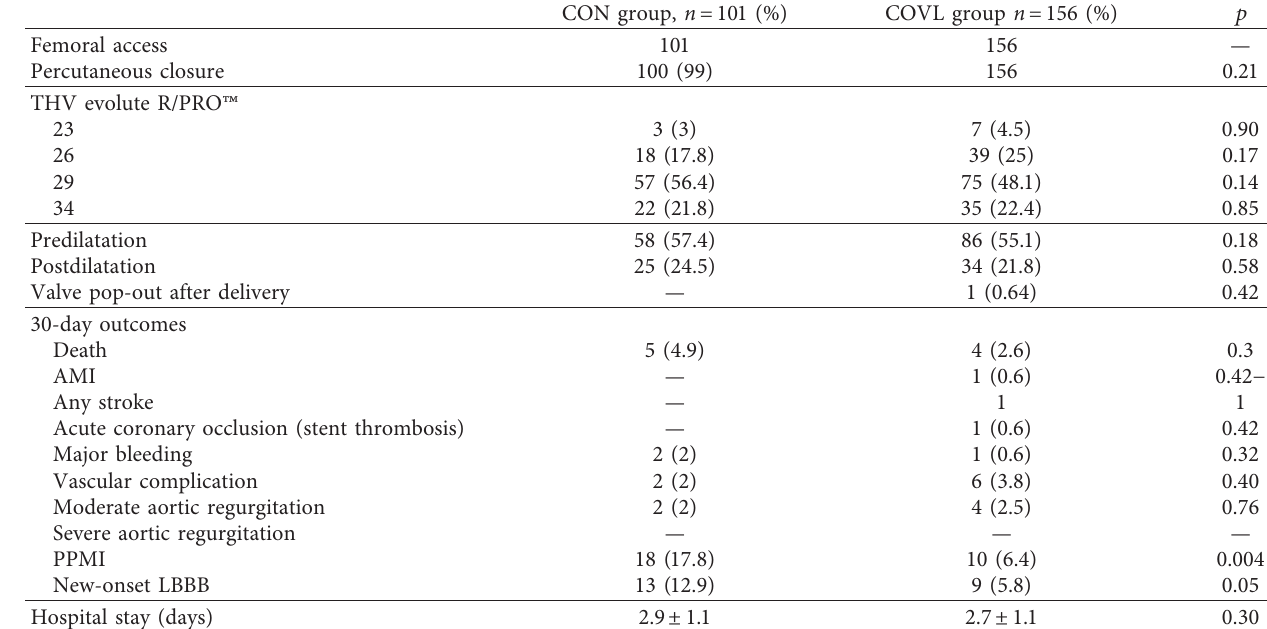
Table 2: Procedural characteristic and 30-day